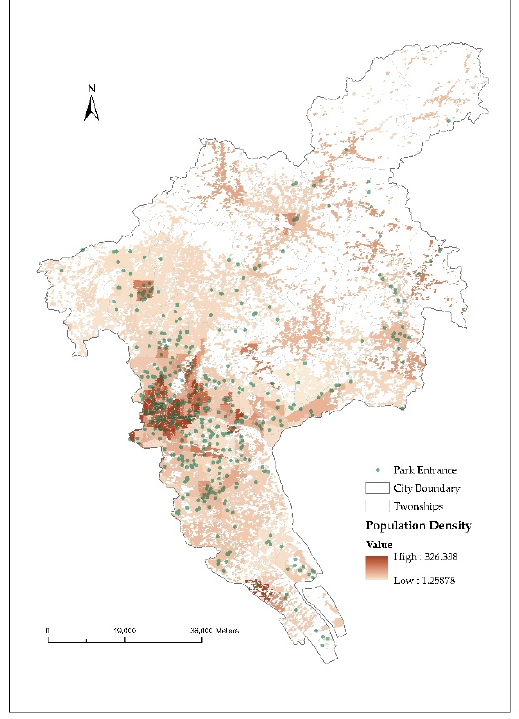
Figure 2. Spatial distribution of all park entrances with green dots and spatial distribution of population density (number of people per pixel; pixel size: 250 m × 250 m) with gradient red spots (the darker the color, the denser it is) in Guangzhou.